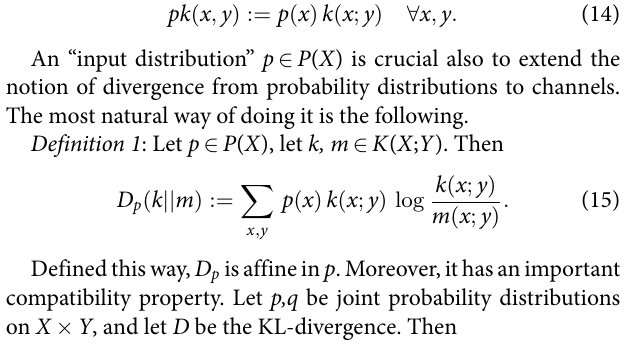
FIGURE 1 | For two binary nodes, the family of product distributions is a surface in a 3-dimensional simplex